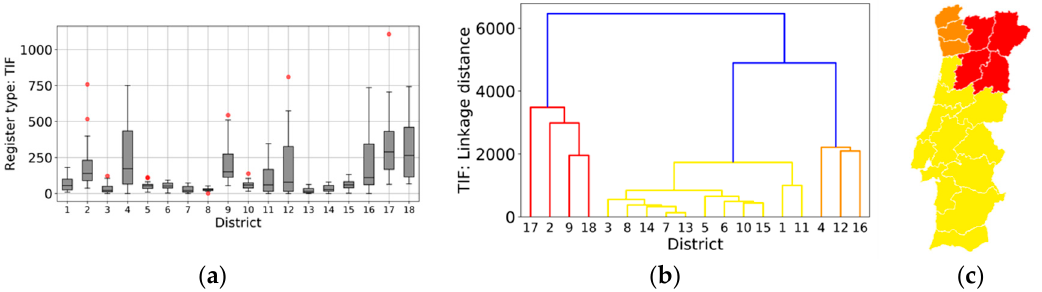
Figure 7. Spatial distribution of Total forest fires with burned area greater than 1 ha and whose cause was investigated (TIF): ( a ) Distribution by district; ( b ) Clusters by annual profile of distribution; ( c ) Clusters in geographic location (cophenetic coefficient: 0.87).